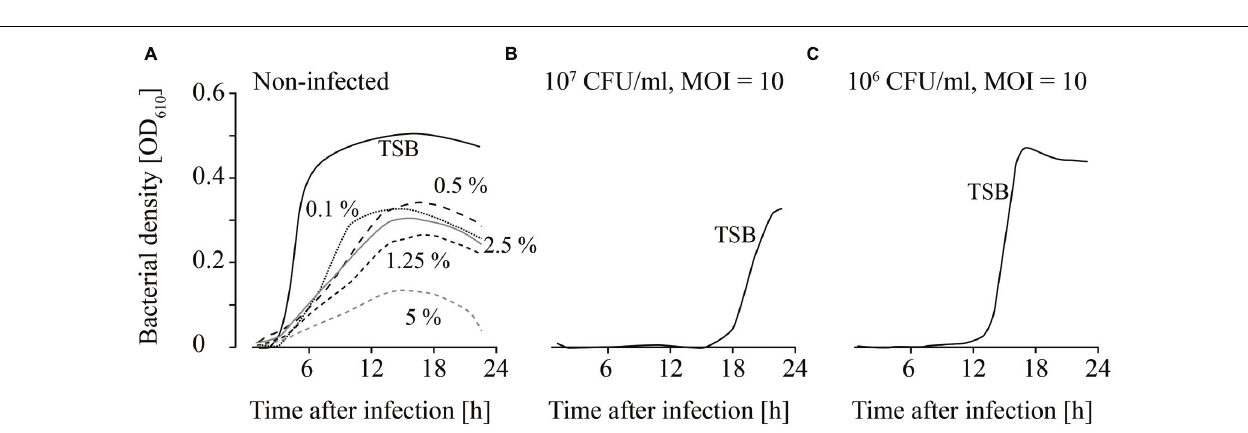
FIGURE 6 | Growth of uninfected (A) and infected (B,C; MOI = 10) L. monocytogenes in TSB containing different Lutensol AO 7 concentrations. Bacteria concentrations at the beginning of the infections were 10 7 CFU/ml (A,B) and 10 6 CFU/ml (C) . All concentrations (0–5%) were tested. For the sake of clarity only the curves of growing bacteria were demonstrated while the others on base line level were not depicted. Moreover, one of four independent experiments is representatively